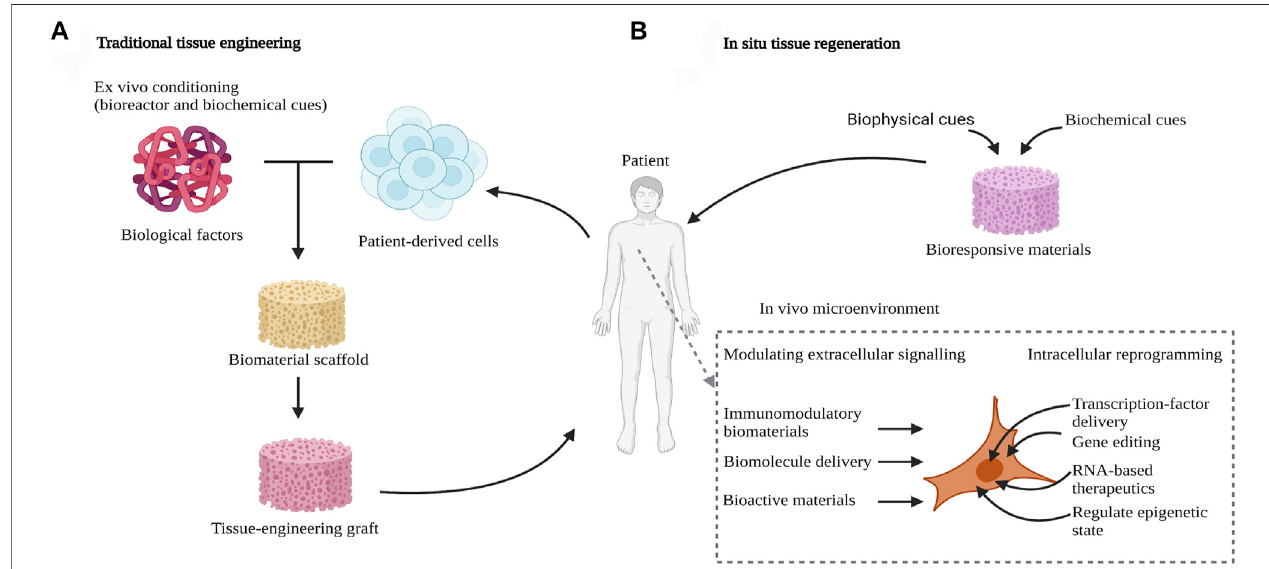
FIGURE 1 | In-situ tissue engineering. (A) Traditional tissue-engineering approaches require the pre-seeding of engineered scaffolds and ex vivo conditioning beforeimplantationintothebody. (B) Insitu tissueregenerationusesbioresponsivematerialsthatharnesstheinnateregenerativeabilityofthebody.Thesematerialsare loaded with biochemical and biophysical cues to recruit endogenous cells for tissue healing (Gaharwar et al., 2020). Copyright 2020, Gaharwar, A.K., Singh, I. &